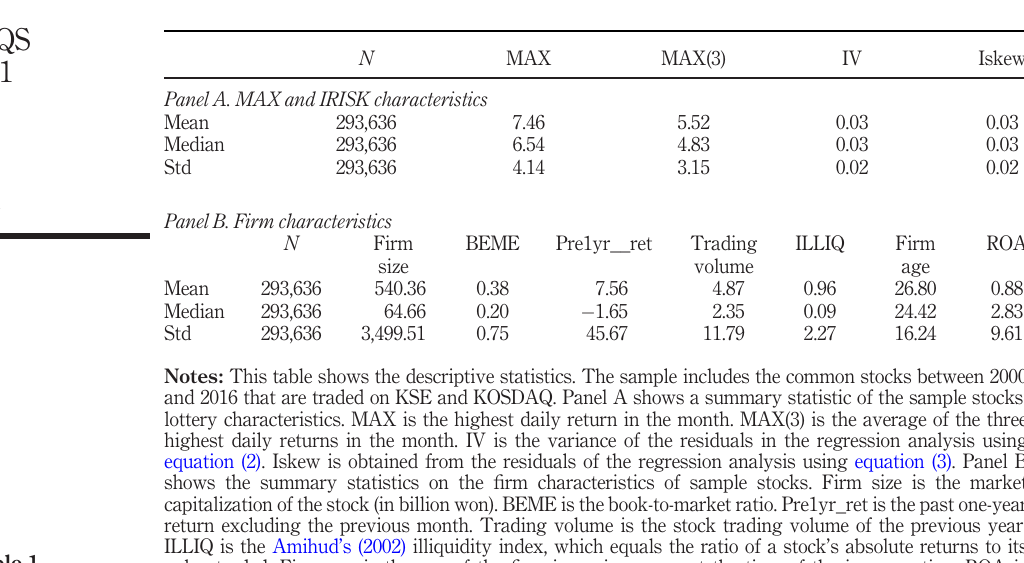
Table 1. Summary